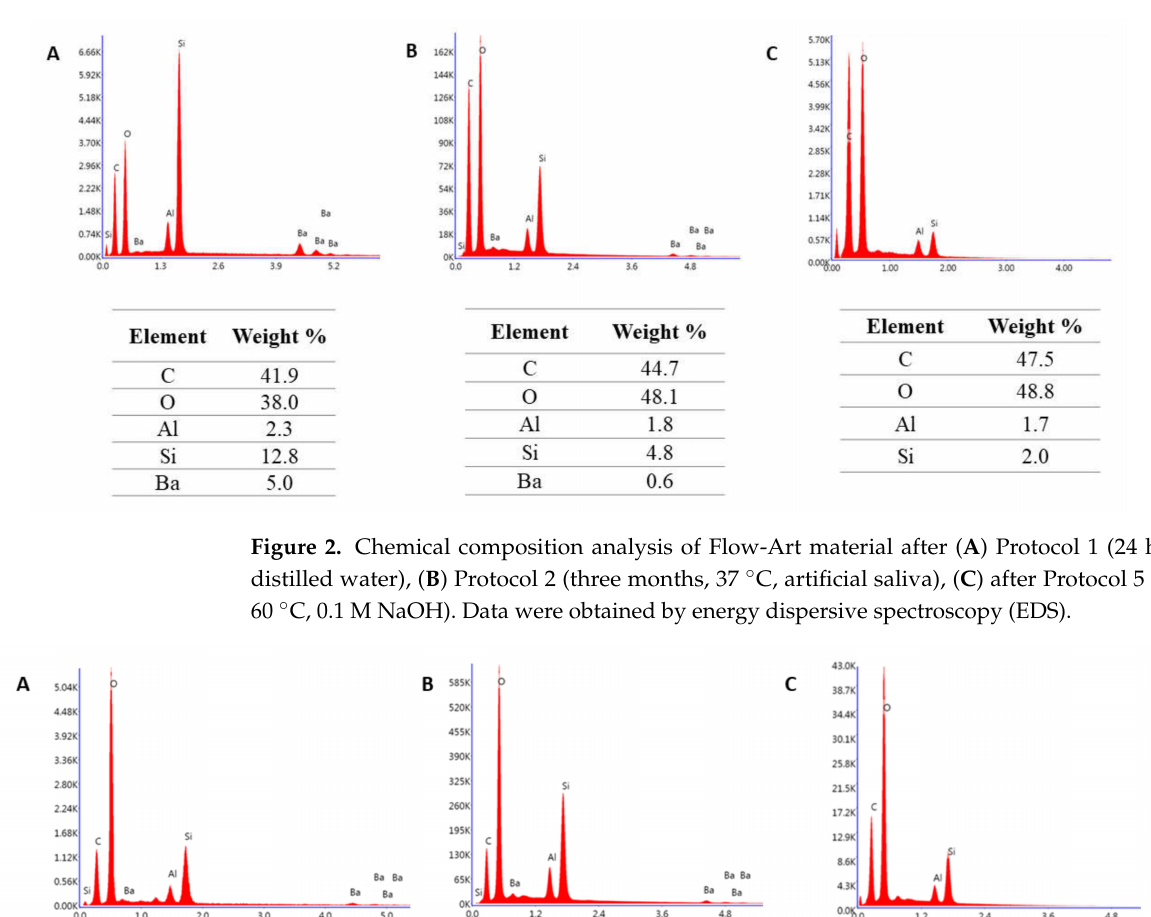
Figure 1. Chemical composition analysis of Resin F material after Protocol 1 (24 h, 37 ◦ C, distilled water). Data were obtained by energy dispersive spectroscopy (EDS).